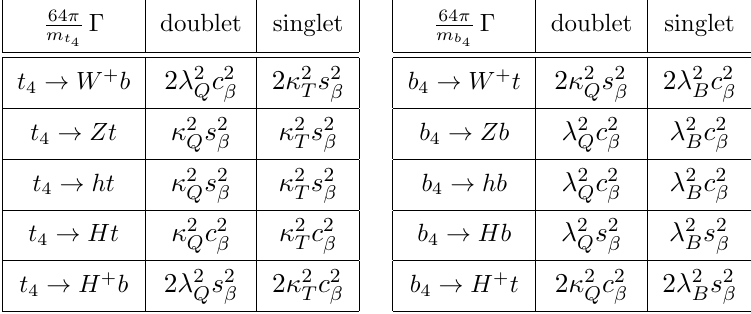
Table 2 . Leading dependence of the t 4 and b 4 decay widths on the Lagrangian parameters in the large mass limit. We use the shorthand notation s (cid:12) = sin (cid:12) and c (cid:12) = cos (cid:12) .